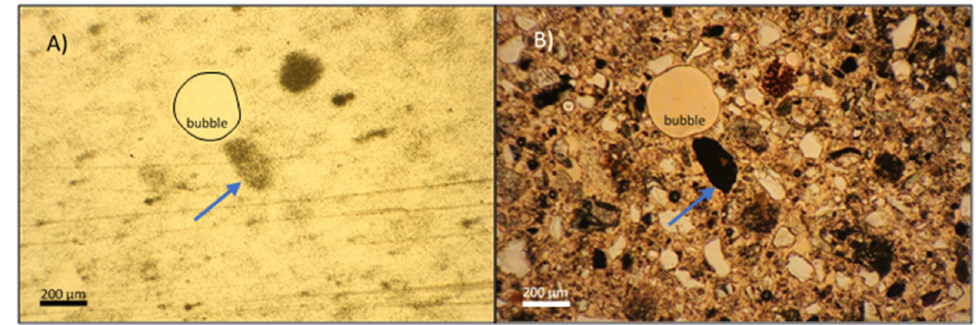
Figure 3. Images from sample GJAST-14-8 (Figure 2). ( A ) Fission-track image at 2.5 × magnification. ( B ) Thin section image in plain light at 2.5 × magnification. Blue arrows indicate a grain with inherent uranium.